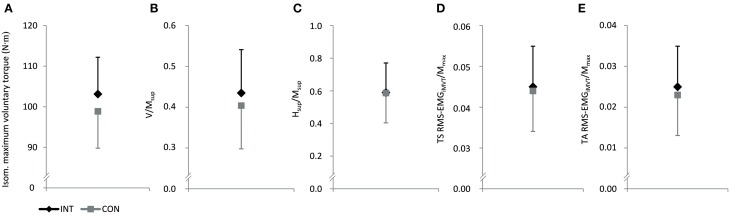
Effect of endurance training (INT) on isometric maximum voluntary torque (A), normalized V-wave (V/Msup, B), normalized H-reflex during iMVC (Hsup/Msup, C) and normalized muscle activity during iMVT (RMS-EMGiMVT/Mmax, D and E). CON, control group; TS, triceps surae; TA, tibialis anterior.